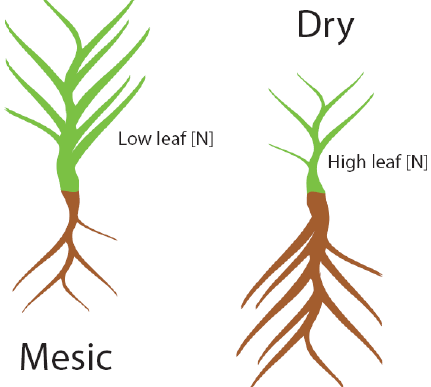
Figure 1. The allocation of biomass under different water regimes. Going from mesic to dry sites, the allocation of biomass shifts to a higher proportion of roots versus leaves and higher leaf N concen-